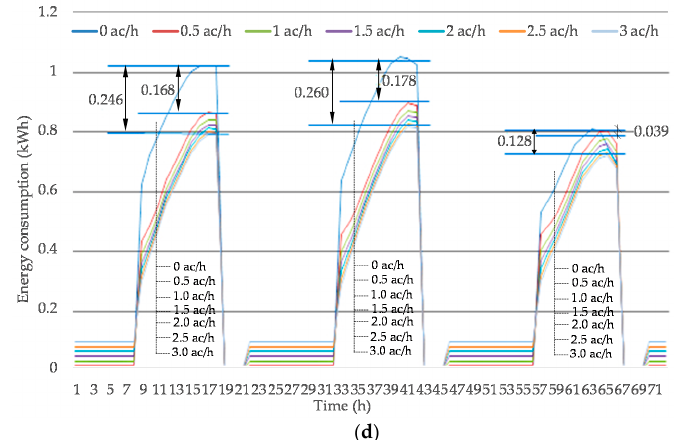
Figure 9. Hourly energy consumption in different ventilation quantity with the above-mentioned good ventilation periods (0:00~9:00) during 3 days, ( a ) Hong Kong; ( b ) Shenyang; ( c ) Changsha; ( d ) Zhengzhou.